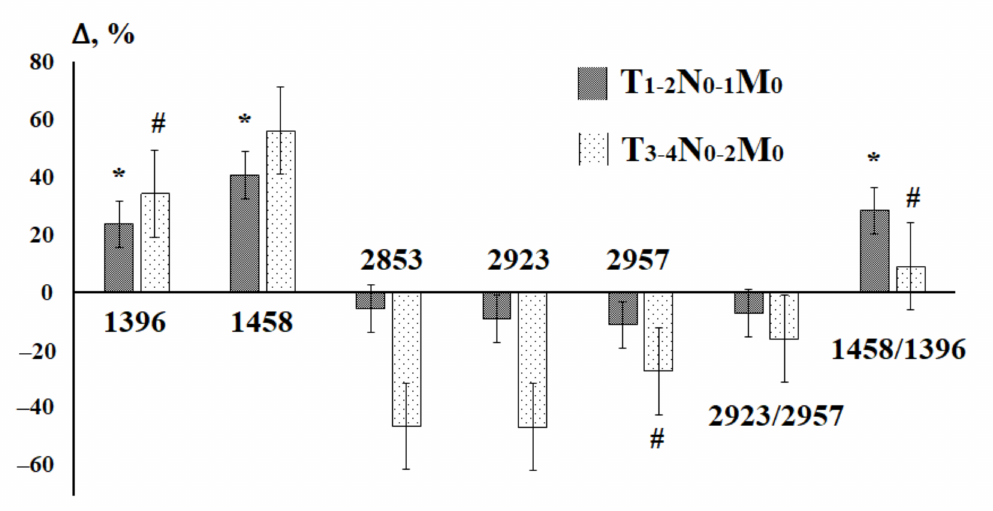
Figure 6. Relative change in the intensity of lipid absorption bands in the IR spectra of saliva in breast cancer patients, depending on the stage of the disease. *—differences with the control group are significant for T 1-2 N 0-1 M 0 , #—differences with the control group are significant for T 3-4 N 0-2 M 0 . A comparison of the previously obtained data on the lipid profile of saliva in ovarian and endometrial cancer [38] shows that in the case of gynecological pathologies, the changes relate to a greater extent to the absorption bands at 2853, 2923, and 2957 cm − 1 (Figure 7), the change in the ratio of 2923/2957 cm − 1 . In the case of breast cancer, the absorption bands at 1396 and 1458 cm − 1 and, accordingly, the ratio of 1458/1396 cm − 1 , which can potentially be used as diagnostic criteria, change to a